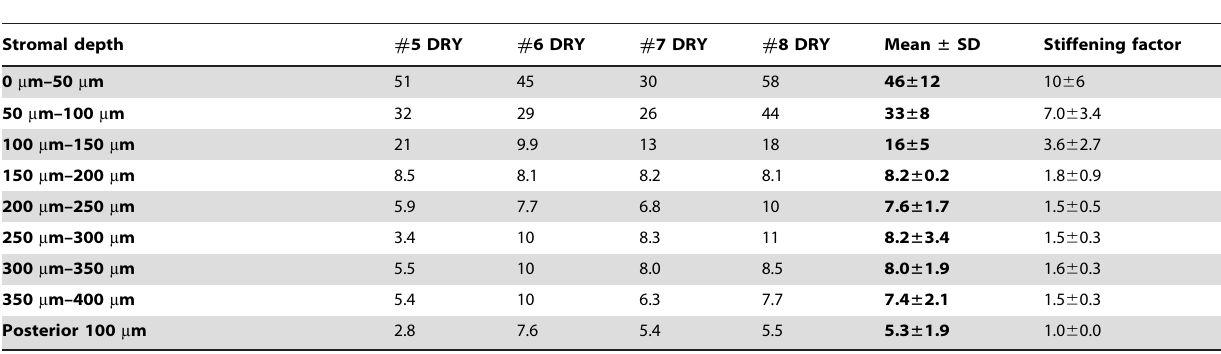
Table 3. Young’s modulus E (kPa) within stromal depth intervals in the DRY group.